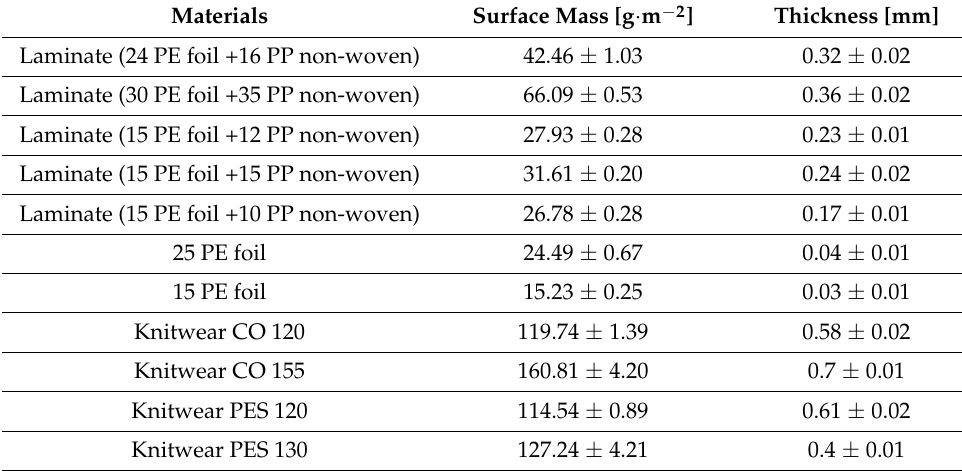
Table 2. Surface mass and thickness of